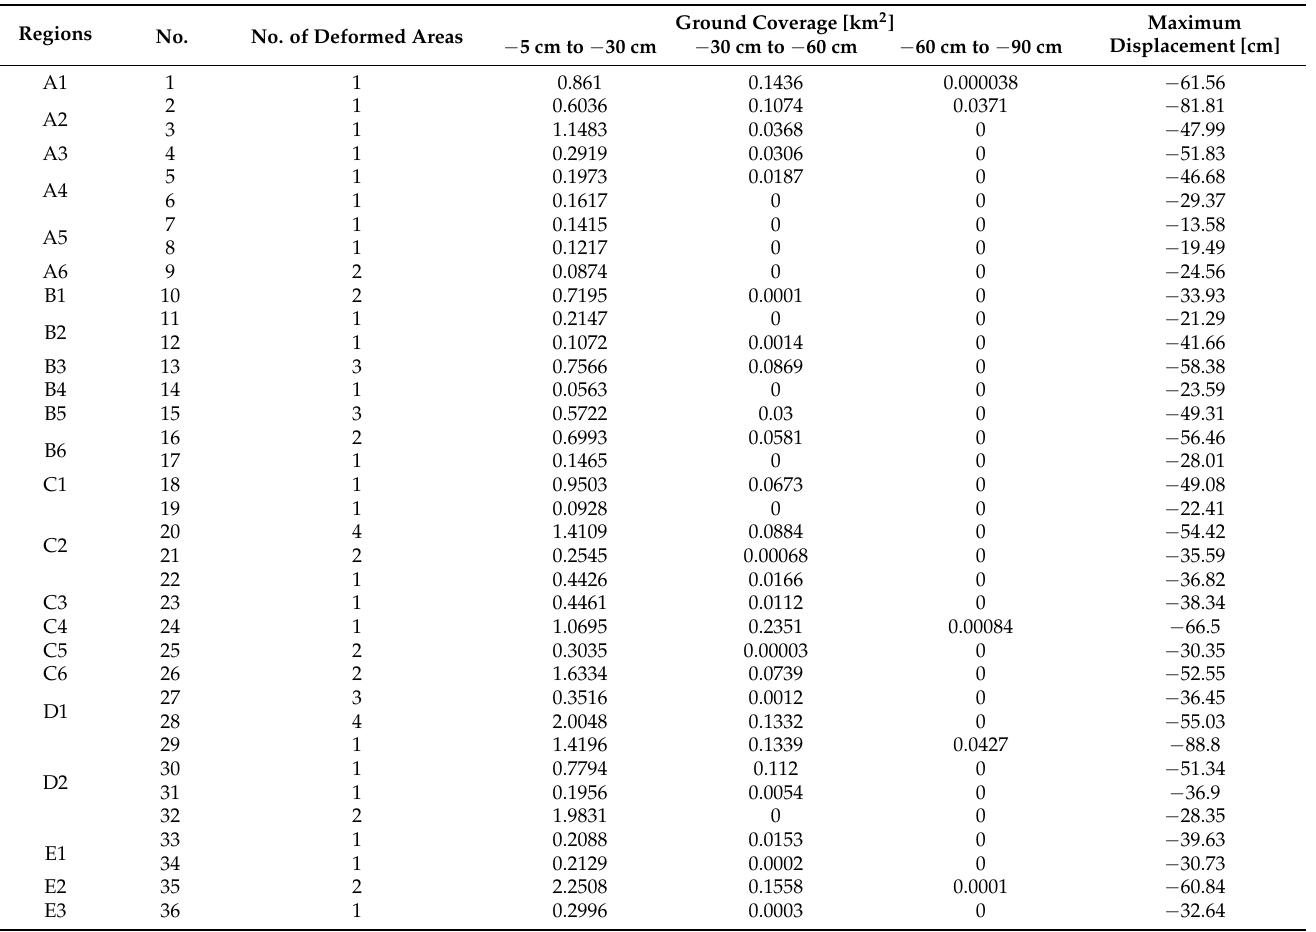
Table A2. The detailed information of displacement in 36 mining